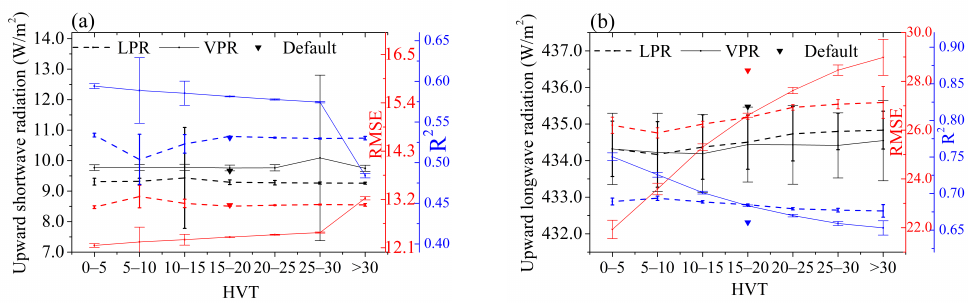
Figure 7. Accuracy assessment of radiation simulations for different scenarios. ( a ) Upward short- wave radiation and ( b ) upward long-wave radiation. Black lines represent values, red lines represent RMSE, and blue lines represent R 2 . Vertical bars represent the standard deviations of the